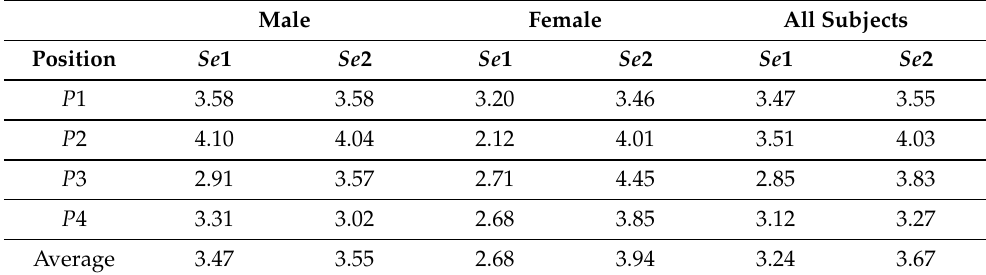
Table 2. The heart rate estimation of Se 1 and Se 2 between males and females are significantly different. This might be due to the physical difference in the thoracic region.